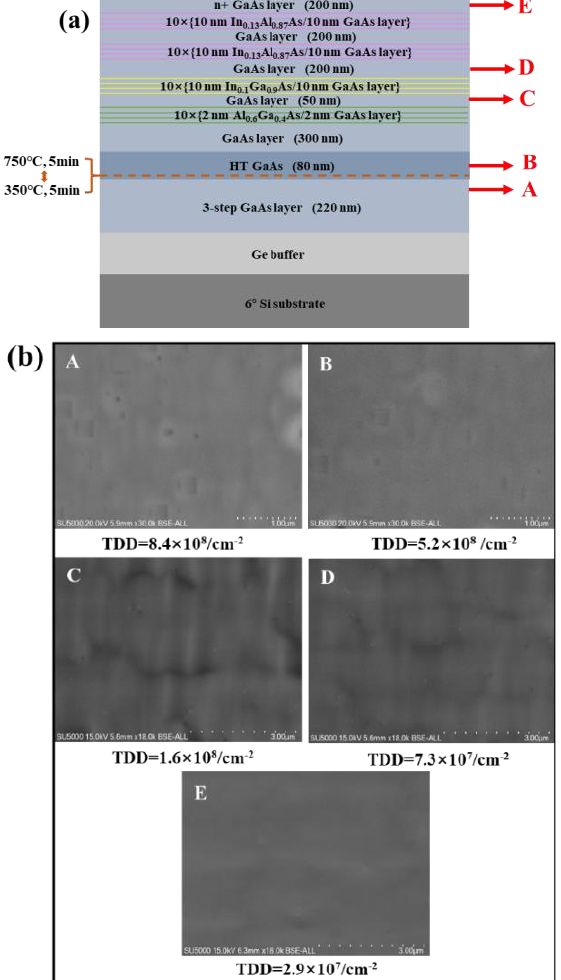
Figure 3. ( a ) Schematic diagram of the complete, optimized GaAs/Ge/Si structure; ( b ) ECCI images at different growth stages, labeled as “A, B, C, D and E” .